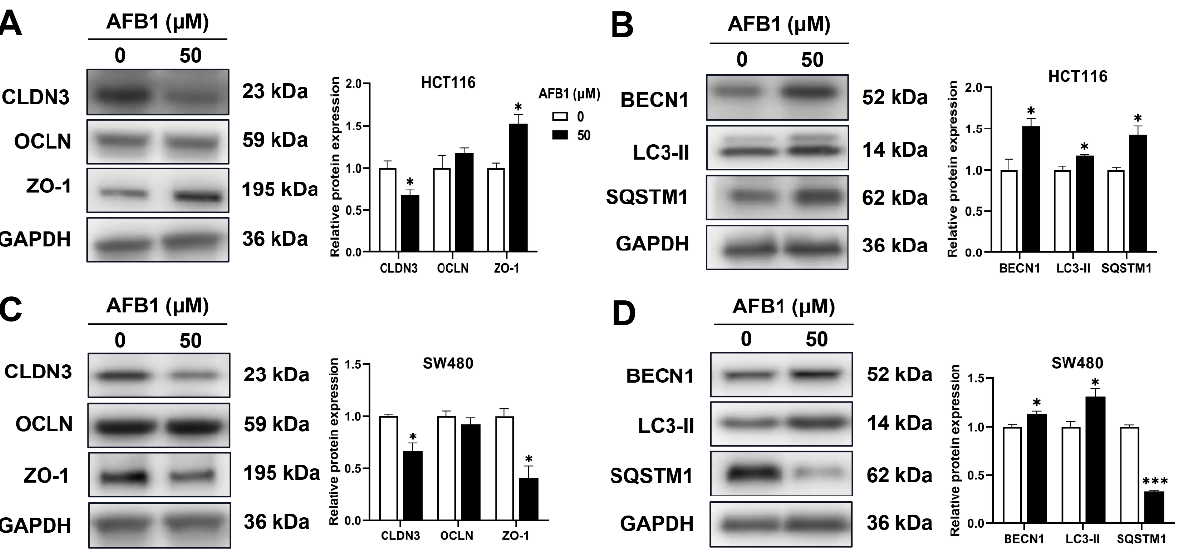
Figure 6. The proteins expression of CLDN3, OCLN, ZO-1, BECN1, LC3-II, and SQSTM1 in AFB1-treated HCT116 ( A , B ) and SW480 cells ( C , D ). * p < 0.05 or *** p < 0.001 indicates statistically significant difference.